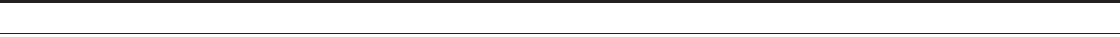
Table 2 . Over-arching theme 2: Barriers to acceptability.